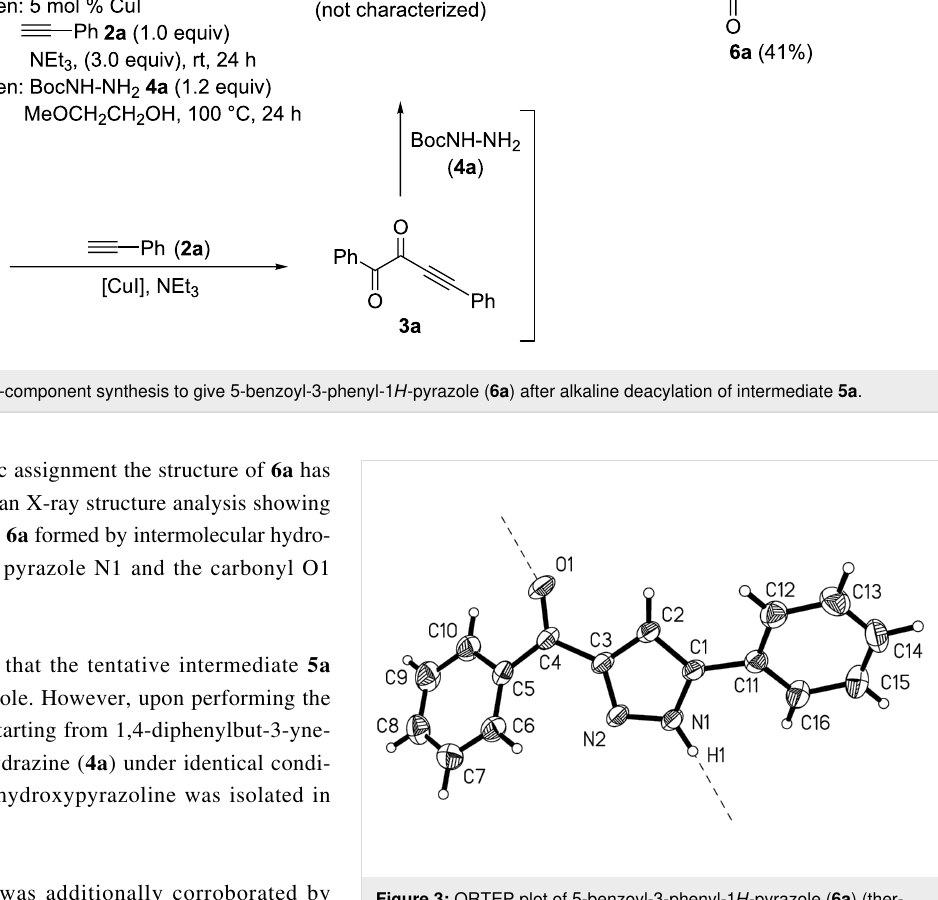
Figure 3: ORTEP plot of 5-benzoyl-3-phenyl-1 H -pyrazole ( 6a ) (ther- mal ellipsoids at 30% probability); the direction of intermolecular N − H···O hydrogen bonding is indicated by dashed